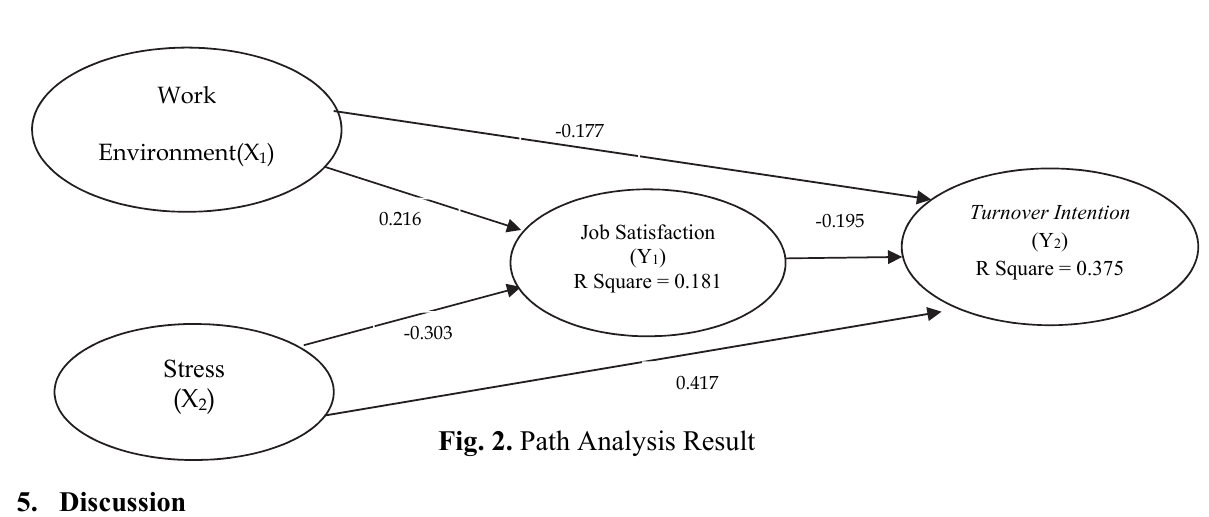
Fig. 2. Path Analysis